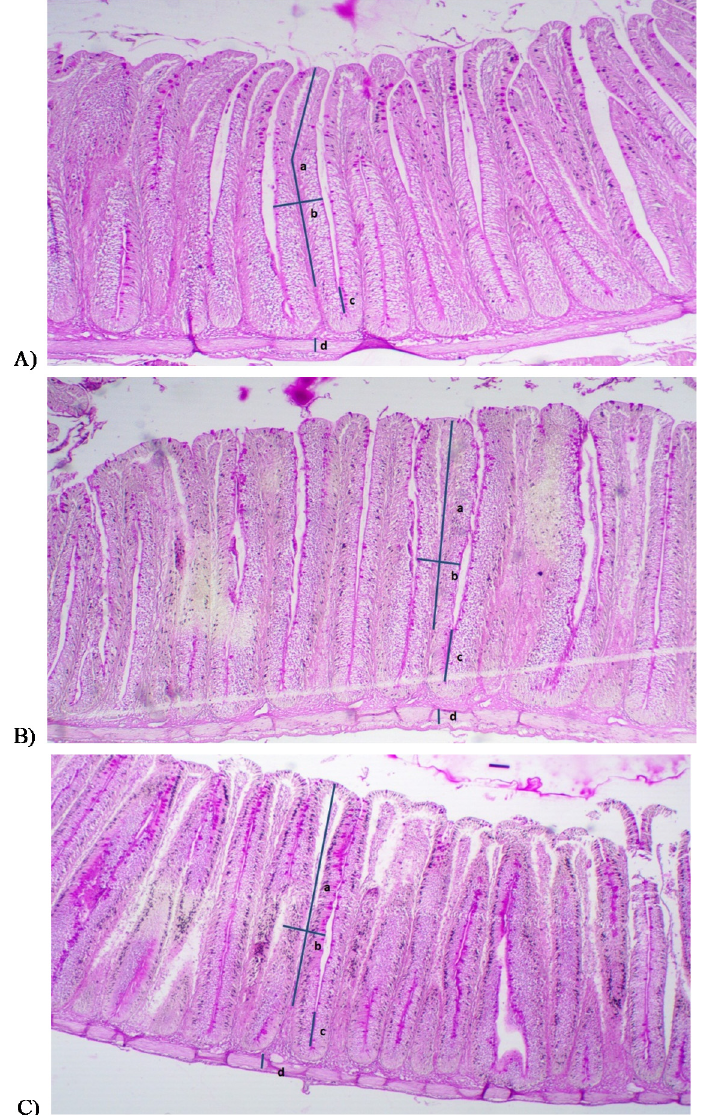
Figure 2. Light microscopy of the anterior portion of the intestine of common carp fed different prebiotic concentrations in the diet: ( A ) control group, ( B ) 1% Bi 2 tos ® , ( C ) 2% Bi 2 tos ® ; a = villi height; b = villi width; c = crypt depth; d = tunica muscular thickness.